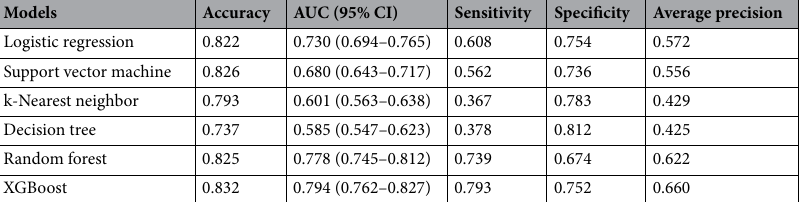
Table 2. Performance comparison of the machine learning models in the validation set. AUC Area under curve, CI Confidence interval, XGBoost Extreme gradient boosting.